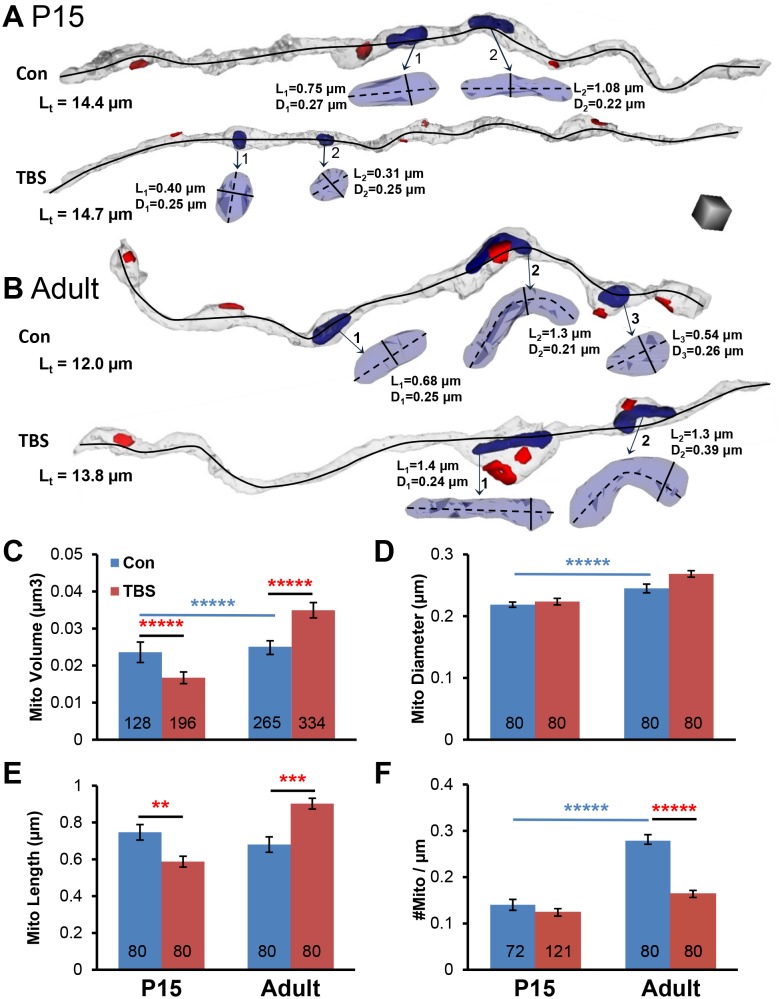
Changes in mitochondrial dimensions in P15 and adult hippocampal axons.(A–B) Representative 3D reconstructions of axons from P15 and adult (Adult) control and TBS conditions at 120 min. (Total axon segment lengths – Lt, black lines – mitochondrial dimensions, length – L, diameter – D, and scale cube is 0.5 µm per side.) (C) Mitochondrial volumes were smaller at P15 and larger in adults in the 120 min TBS vs. the control condition (F1,919 = 74.4, p<0.001, n = all mitochondria for all measured axons). (D) Neither P15 nor adult mitochondria showed differences in diameter between conditions (n = 320, F1,316 = 0.37, p=0.55), although adult mitochondria were wider than P15 mitochondria (n = 320, F1,316 = 37.5, p<0.001). (E) P15 mitochondria were shorter and adult mitochondria were longer at 120 min after TBS vs. the control condition (n = 320, F1,316 = 30.0, p<0.001). (F) Mitochondria per axon segment length (#mito/µm) was greater in adults than P15 in the control condition (F1,349 = 73.2, p<0.001, blue bar and stars), and the adult mitochondria frequency was significantly reduced in the 120 min post TBS versus control condition (F1,349 = 45.6, p<0.001). (Numbers at the base of each bar indicate the total number of mitochondria in each group. All the mitochondrial volumes were measured. See Table 1 and Materials and methods for sampling details.).